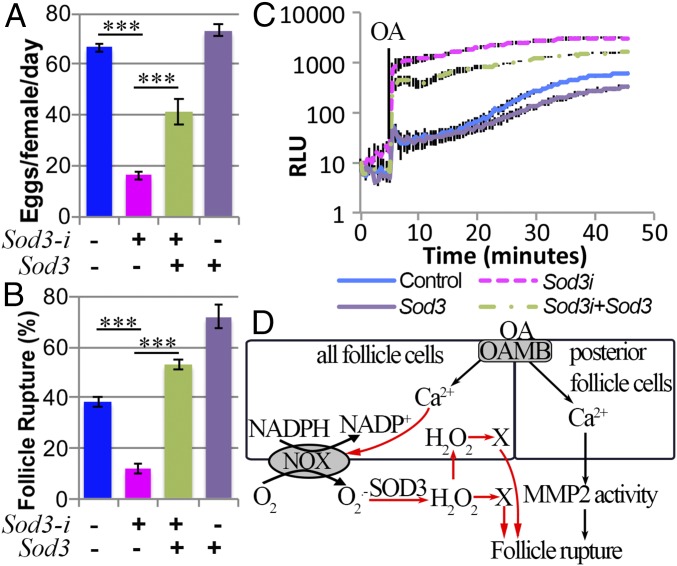
SOD3 in mature follicle cells is required for ovulation. (A and B) Quantification of egg laying (A) and OA-induced follicle rupture (B) using females with 44E10-Gal4 driving Sod3-i and/or Sod3::3xHA expression. Forty to 50 females were used in A, and the numbers of follicles used in B are 219, 240, 227, and 237. (C) l-012 Luminescence-dependent O2•− quantification in mature follicles with 44E10-Gal4 driving Sod3-i and/or Sod3::3xHA expression. Note the y axis is different from those in Fig. 3. Mature follicles were stimulated with 20 μM OA at the 5-min point. (D) A schematic diagram shows the signaling pathways downstream of the OA/OAMB in mature follicle cells to regulate follicle rupture. ***P < 0.001. RLU, relative luminometer unit.